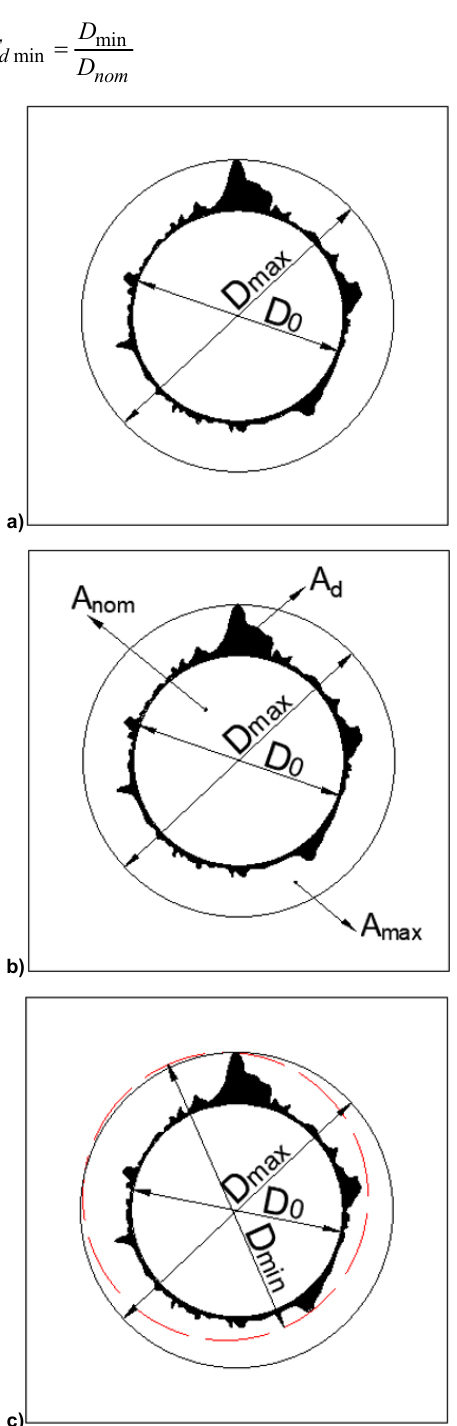
Figure 4. Determination of delamination factors: a) Conventional delamination factor ( F d ), b) Adjusted delamination factor ( F da ), and d) Minimum delamination factor ( F dmin